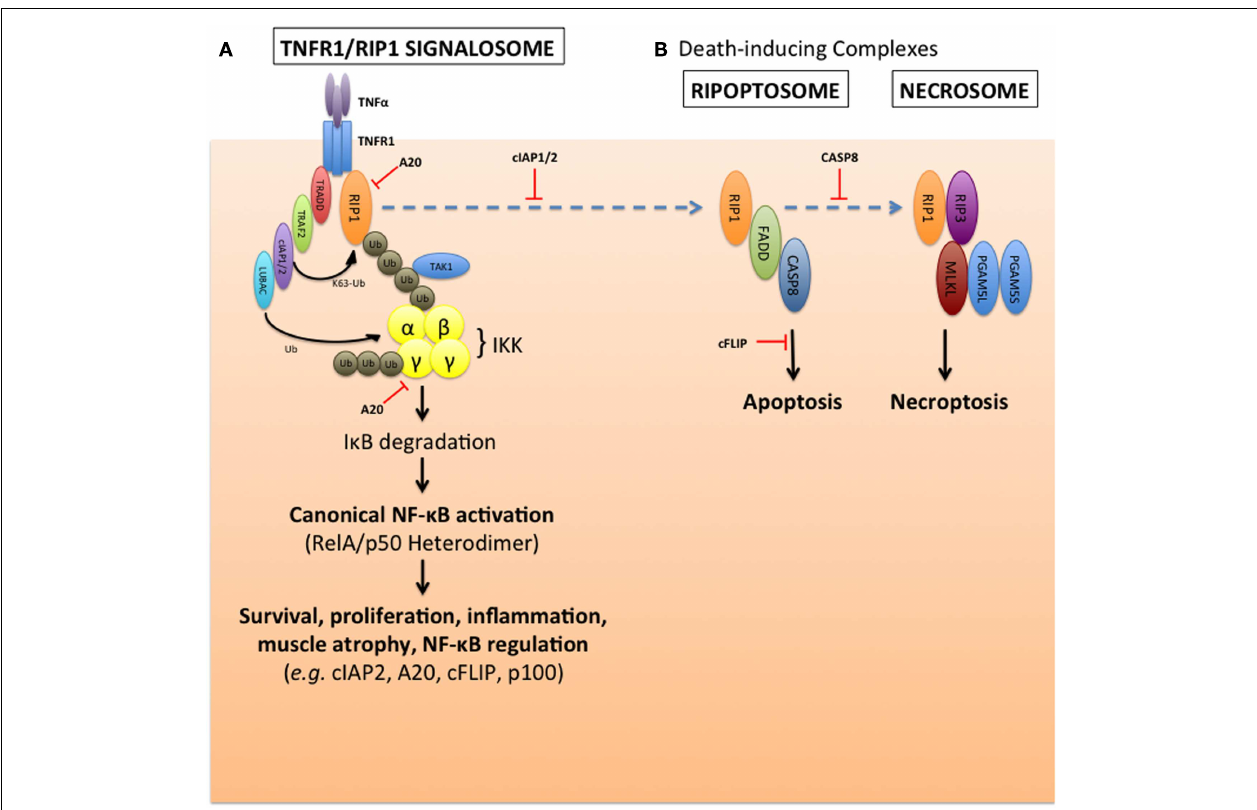
FIGURE 2 | cIAP1/2 regulation ofTNF α -induced canonical NF- κ B pathway activation and suppression of default death pathways . (A) The E3 ubiquitin ligases cIAP1 and cIAP2 are required forTNF α activation of canonical NF- κ B signaling, and to suppressTNF α